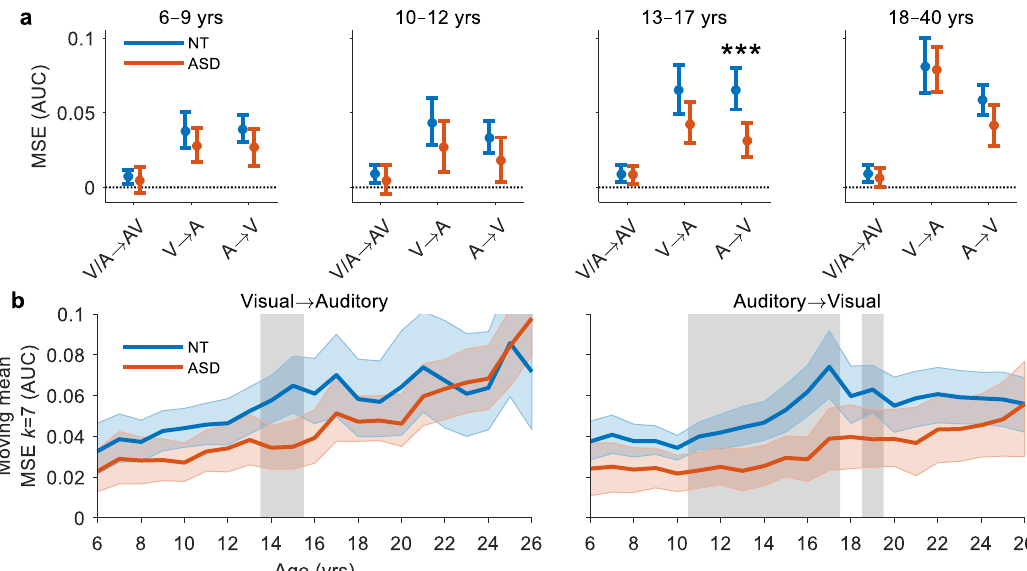
Fig. 6 Modality switch effects. a Mean MSE for each condition by age group. MSEs were quanti fi ed by the area between the CDFs of the switch and repeat trials (Eq. 9). Error bars indicate 95% CIs (bootstrapped). Asterisks indicate signi fi cant group differences ( p < 0.05, two-tailed permutation tests, t max corrected). b Mean MSE for visual to auditory (left panel) and auditory to visual (right panel) switches calculated with a moving window k of 7 years in increments of 1 year from 6 – 24 years for NT (blue trace) and ASD (red trace) participants. Coloured error bounds indicate 95% CIs (bootstrapped). Gray shaded regions indicate signi fi cant group differences ( p < 0.05, two-tailed permutation tests, FDR